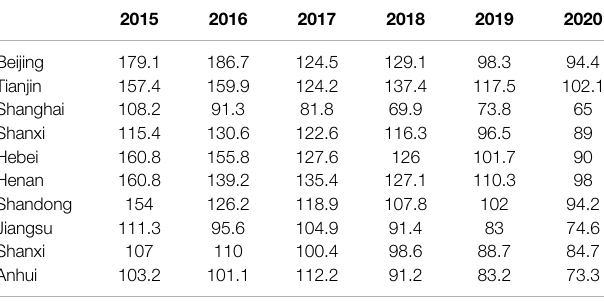
TABLE 1 | Annual average concentration of PM 2.5 inhaled in seven provinces and three cities.